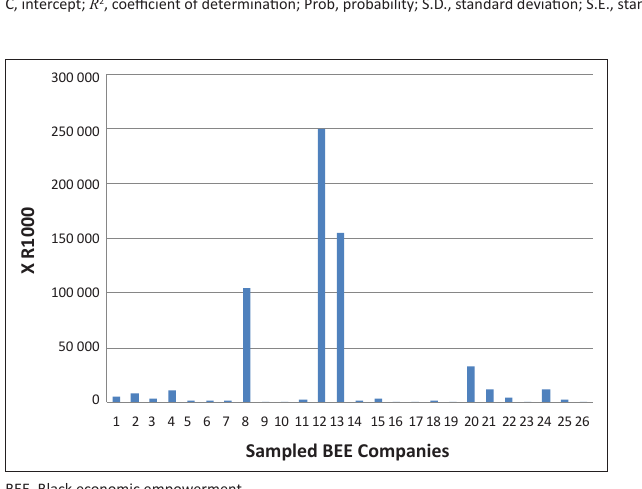
FIGURE 2: Black economic empowerment and investment (2011) (Rand x